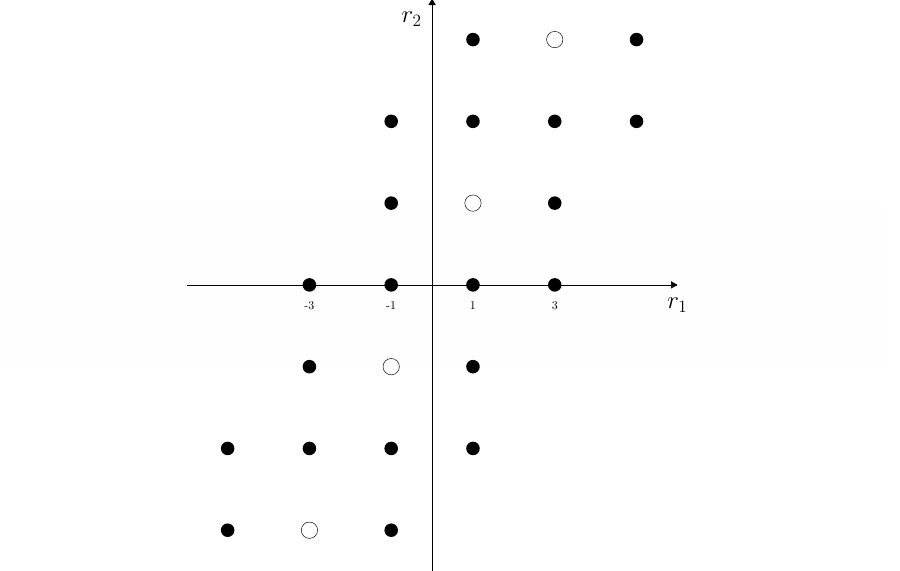
Figure 5 . The r lattice of local F